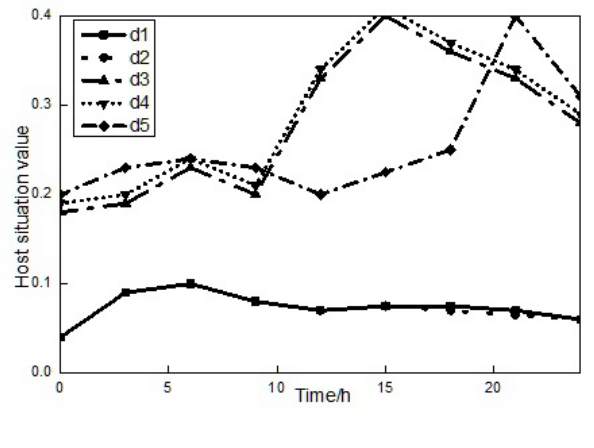
Fig. 6 Host security